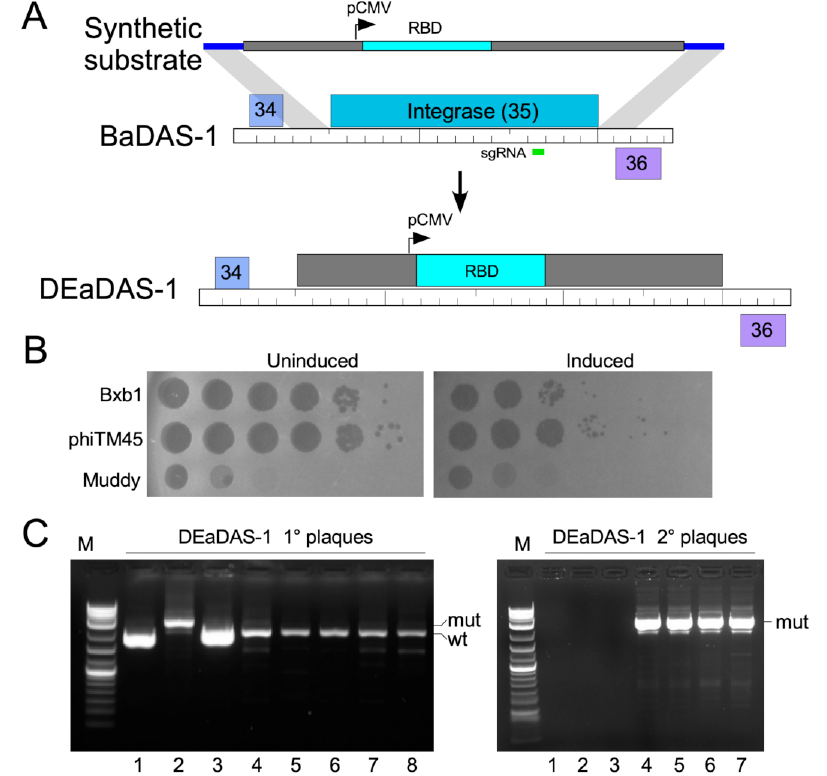
Figure 3. Construction of a DNA Encoded and Displayed Antigens of SARS-CoV-2 (DEaDAS) recombinant phage. ( A ) The integrase gene (blue) of phage phiTM45 was replaced with a mammalian expression cassette (gray box) containing the RBD of SARS-CoV2 (aqua) driven by a CMV promoter (pCMV). The location of the sgRNA target selecting against parent phiTM45 (green) is indicated. Regions of homology between the synthetic substrate and phiTM45 are indicated (blue line), and the structure of recombinant phage DEaDAS-1 is shown below. ( B ) sgRNA induction for selection against the integrase gene reduces Bxb1 and phiTM45 plaquing by at least two orders of magnitude. ( C ) Primary plaques (left panel) recovered from CRISPY-BRED engineering were screened by PCR, and a candidate recombinant (candidate 2) was plaque purified and secondary plaques (right panel) re-screened by PCR; all candidates are